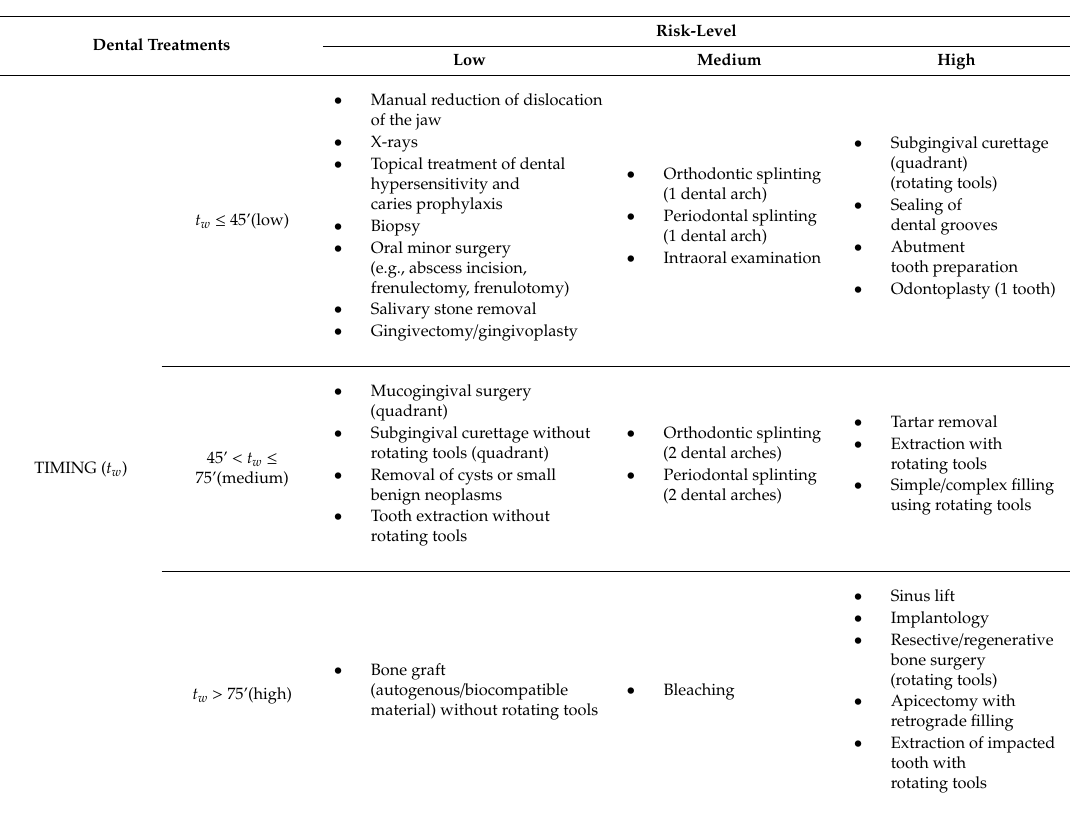
Table 2. Grouping of the dental treatments on the basis of the time and risk variables, and the risk of